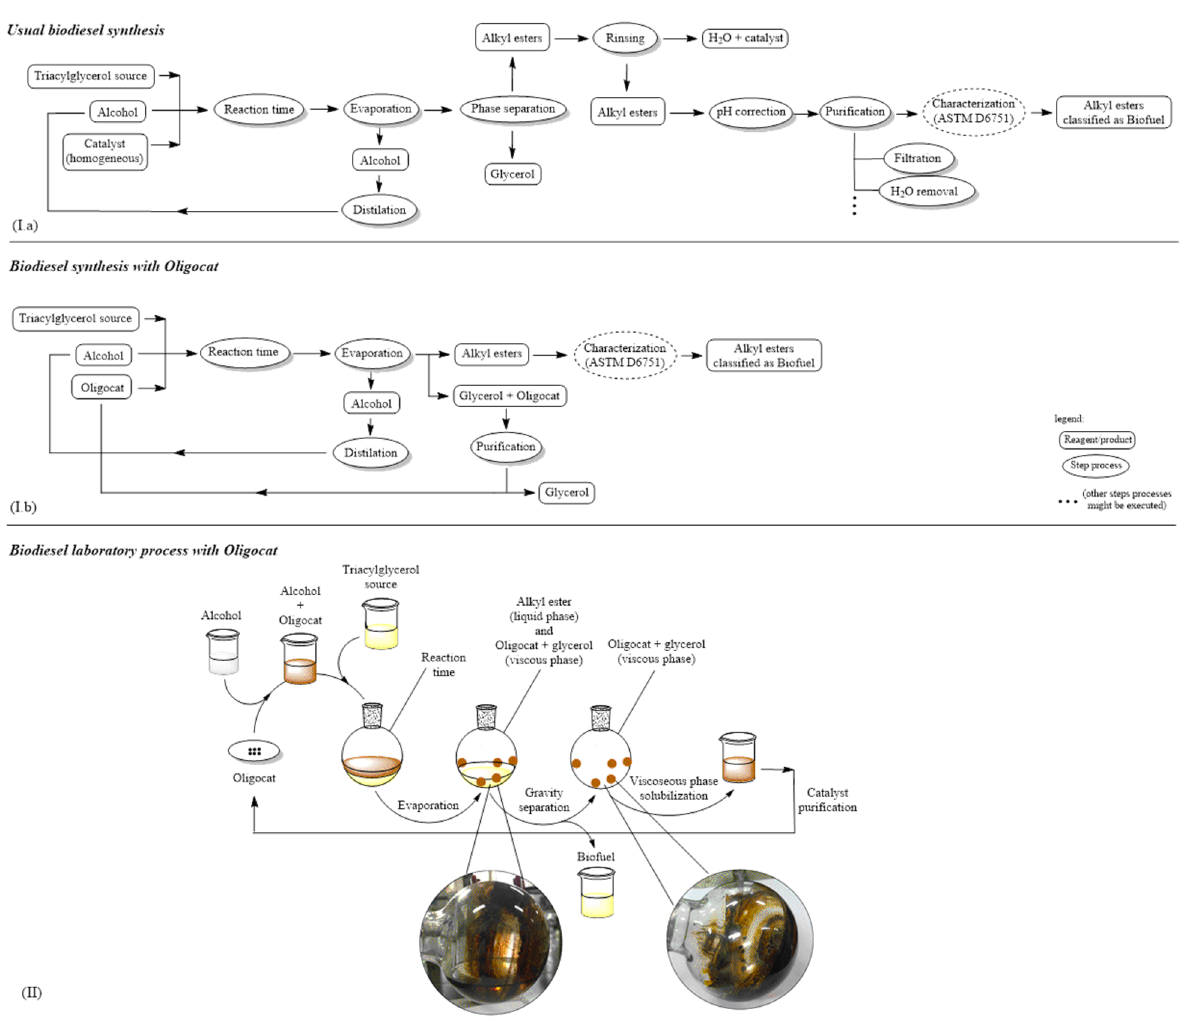
Figure 13. Biodiesel synthesis flow charts and laboratory synthesis steps applying Oligocat. ( Ia ) Biodiesel synthesis flow chart applying conventional homogenous alkali catalysts. ( Ib ) Biodiesel synthesis flow chart applying Oligocat. ( II ) Biodiesel reaction steps with Oligocat.